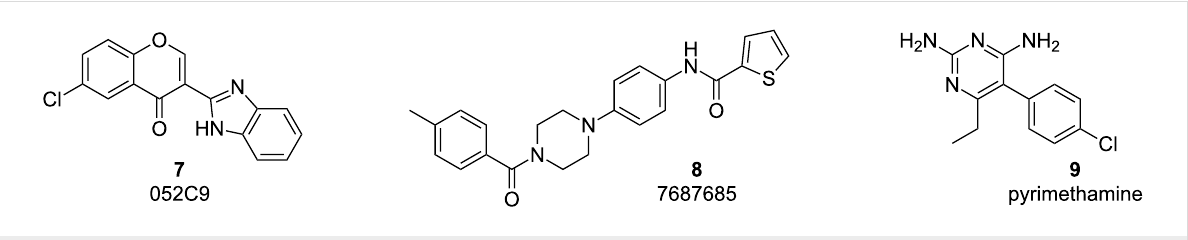
Figure 5: Compounds shown to reduce SOD1 expression.